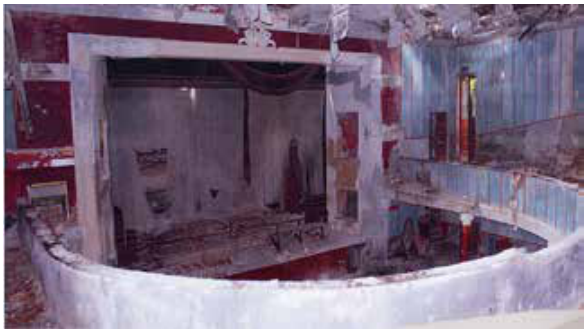
Figure 15. Current photograph of the interior of the 'Teatro Figure 17. Digital reconstruction of the interior of the 'Teatro civico di Susa'. civico di Susa'. Modeling and rendering by F.